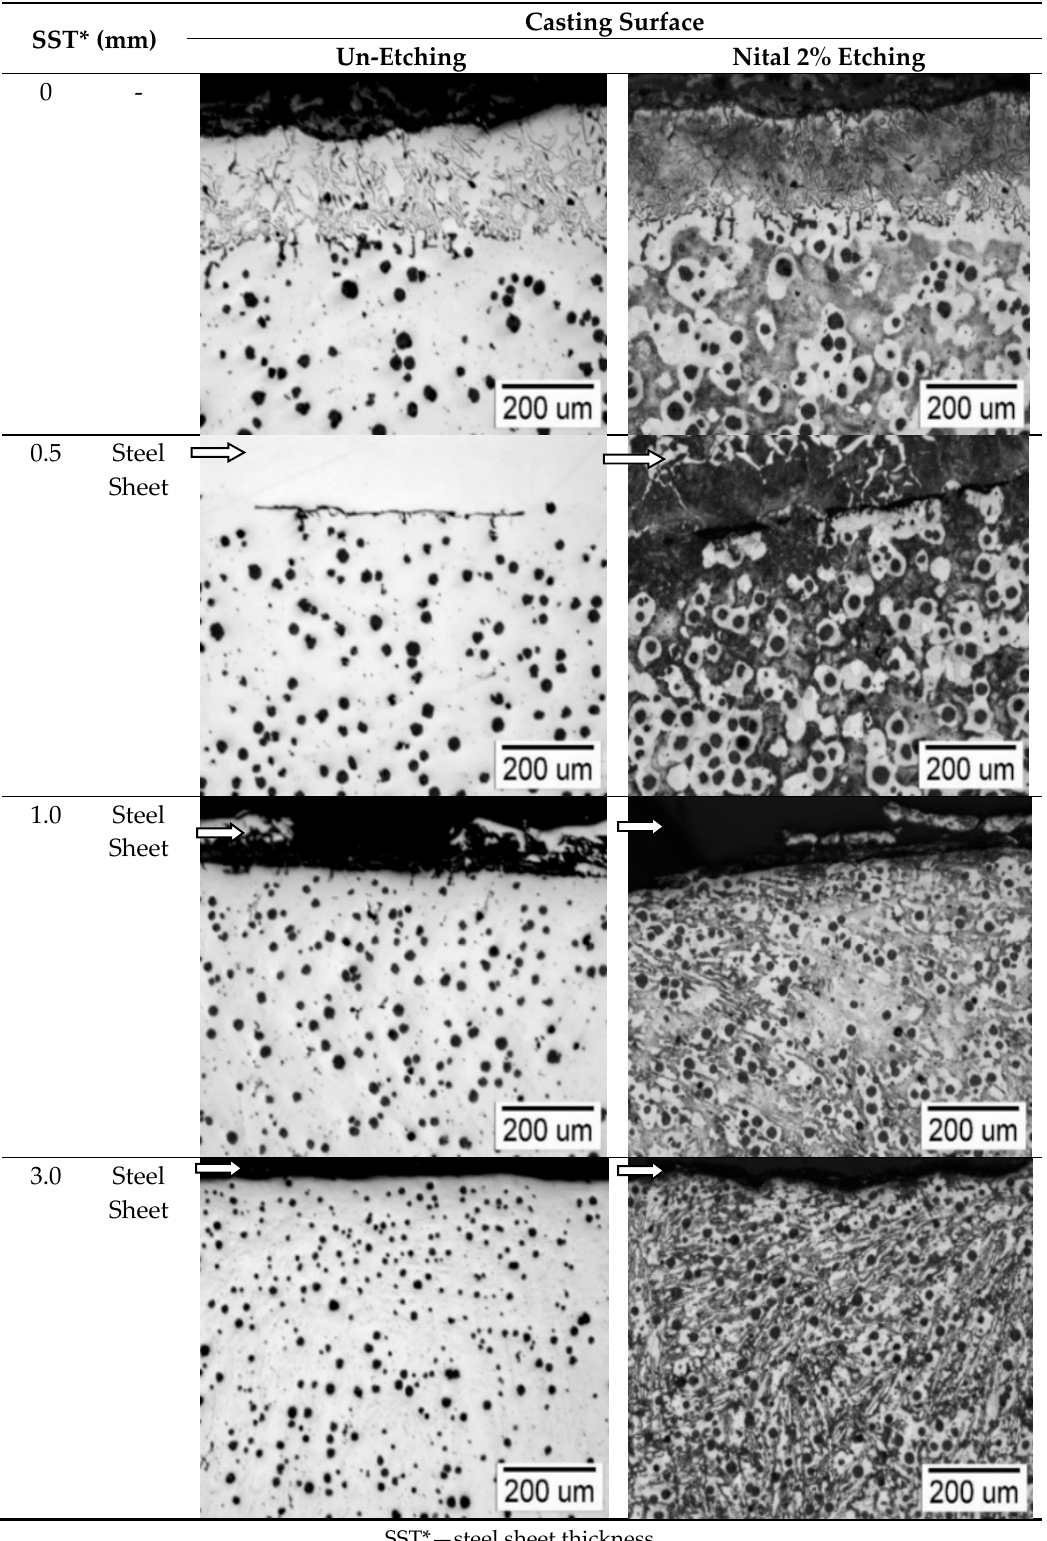
SST*—steel sheet thickness. Figure 8. Structure in the ductile iron casting surface layer (un-and Nital 2% etching) at different thicknesses of the steel sheet (SST) applied on the inner mould surface, before pouring.